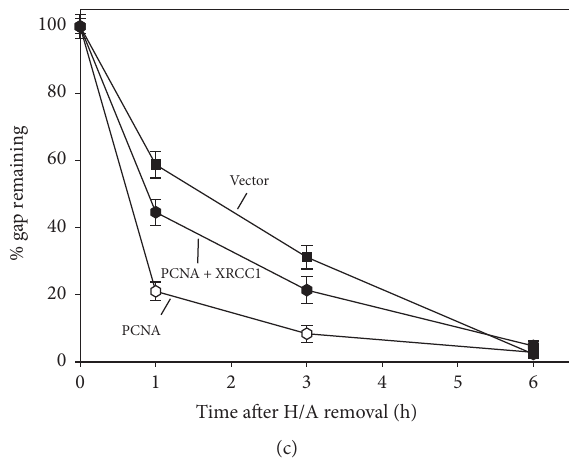
Figure 8: The effect of XRCC1 overexpressed on the gap-filling during repair of UV-induced DNA lesions. ((a) and (b)) Similar to the procedures described in Figures 1 and 3, yet colcemid was excluded. (a) AGS cells were transiently transfected with pCMV XRCC1 plasmids (open circle) or not (closed circle). (b) Cont. for control, that is, cells without treatment. AGS cells were transfected with wt. PCNA or pCMV- XRCC1 or empty vector. Time points: 0–8 h after H/A removal. Histograms of both panels: 𝑥 -axis: forward scattering (relevant to particle size); 𝑦 -axis: cell counts. (c) Similar to procedures described in Figure 1, colcemid was present, and AGS cells transfected with empty vector or plasmid EGF-PCNA with or without pCMV XRCC1 were used.